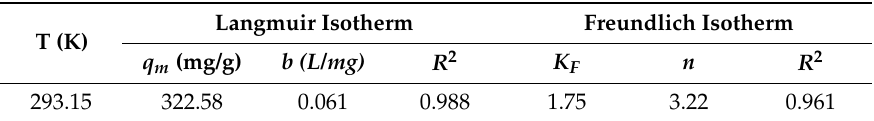
Figure 12. ( a ) Langmuir and ( b ) Freundlich isotherm modeling of the adsorption of Pb(II) on MOF-5–CMC beads.